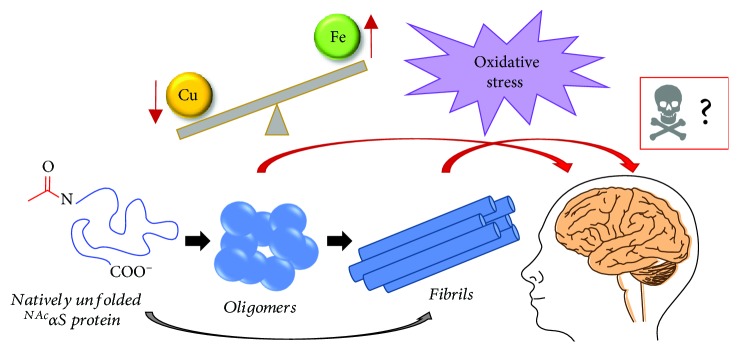
Schematic diagram of αS aggregation.